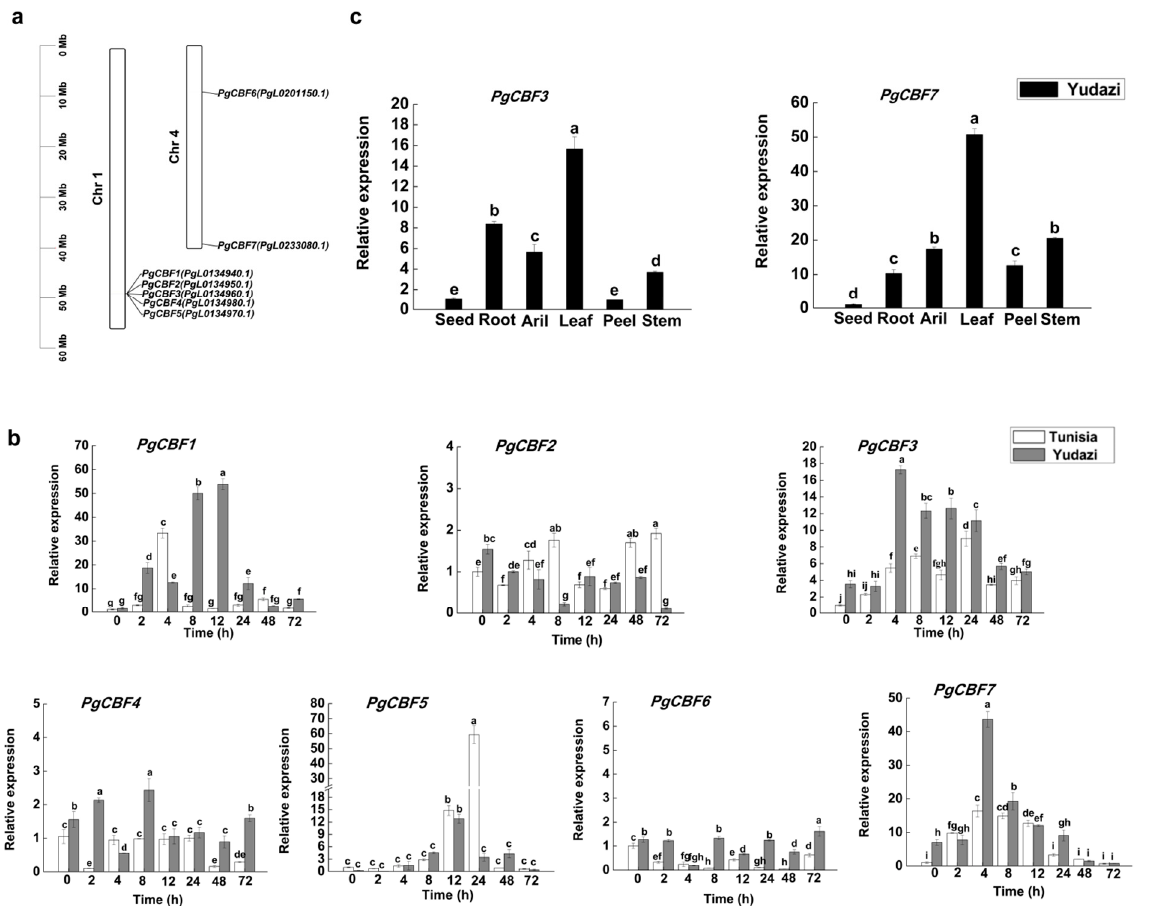
Figure 1. Chromosome distribution and the expression profiles of PgCBF gene family members from pomegranate vs. ‘Tunisia’ and ‘Yudazi’ at 4 °C. ( a ) Chromosome distribution of CBF genes in Punica granatum genome. Chr 1 and 4 represent 2 chromosomes. Gene position and chromosome length are measured with the left ruler (bp); ( b ) Expression profiles of PgCBF gene family members under 4 °C; ( c ) Expression patterns of PgCBF3 and PgCBF7 genes in six tissues from ‘Yudazi’. Different letters present significant differences ( p < 0.05).